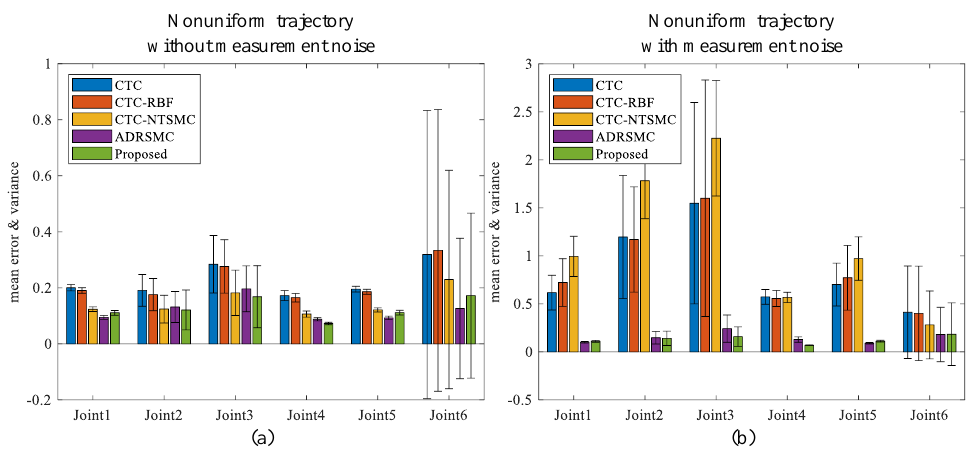
Figure 9. Comparison mean error and variance of joint position for non-uniform trajectory tracking. ( a ) the results without the addition of joint measurement noises, ( b ) the results with the addition of joint measurement